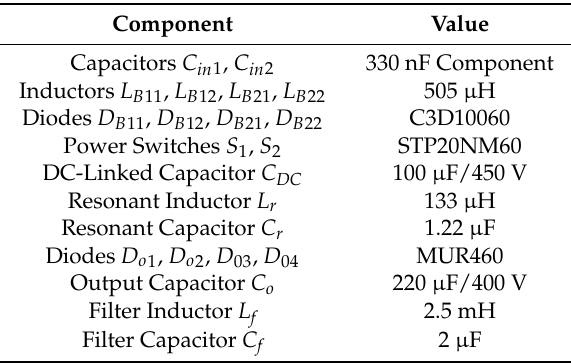
Table 2. Key components utilized in the presented LED driver.